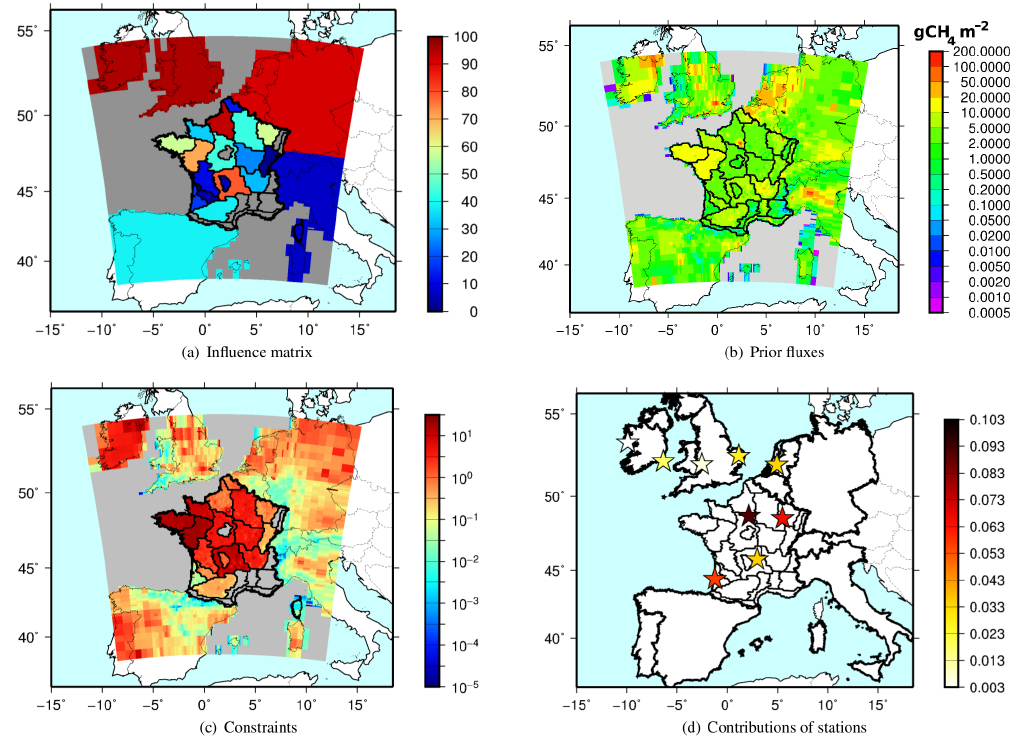
Figure 6. Constrained areas in the regional run (described in Sects. 3 and 3.3). The influence matrix ( a , influence for each grid cell given in % over the whole year) is de-aggregated according to prior fluxes (b) to obtain the constraints (c) : the annual sum of constraints on CH 4 emissions by the atmospheric data is shown on a logarithmic scale ( c , non-dimensional). Red is for a strong constraint. The spatial resolution is the grid of the model (see Fig. 2). Only fluxes independent from initial and boundary conditions are used (see Sect. 4.1). Black bold lines show the borders of the regions; grey regions are never constrained. The relative contributions of the stations in the inversion, averaged over the year are shown on an arbitrary scale (d) , white being for a small